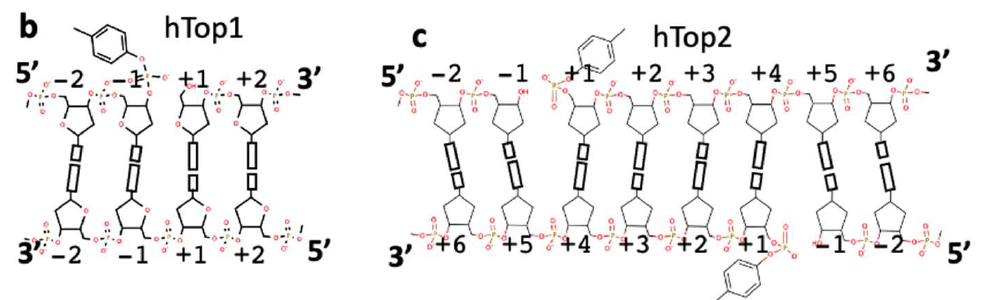
Figure 1. Human Top1 and Top2 regulate DNA topology at a transcription bubble. ( a ) In the post-mitotic cells of the central nervous system-human Top1 and human Top2 β are expected to be active in regulating DNA topology near transcription bubbles. The only DNA replication in post-mitotic CNS cells will take place in mitochondria; and careful design may be needed to ensure that damage to replicating mitochondrial DNA does not take place [27]. RNAPII, RNA polymerase II, is shown in contact with Top1 [28]. ( b ) Human Top1 cleaves a single DNA strand forming a 3’ phosphotyrosine. By convention both cleaved and non-cleaved strands are numbered relative to the single DNA-cleavage site. ( c ) Human Top2 (Top2 α or Top2 β ) can cleave both DNA strands forming two 5’ phosphotyrosines. By convention both strands are numbered relative to the two 4-base-pair staggered DNA-cleavage sites.